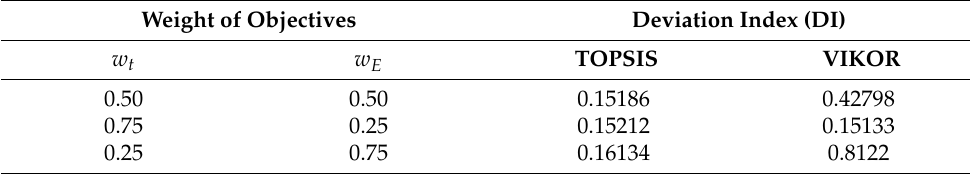
Table 8. Re-evaluation of the selected solutions using